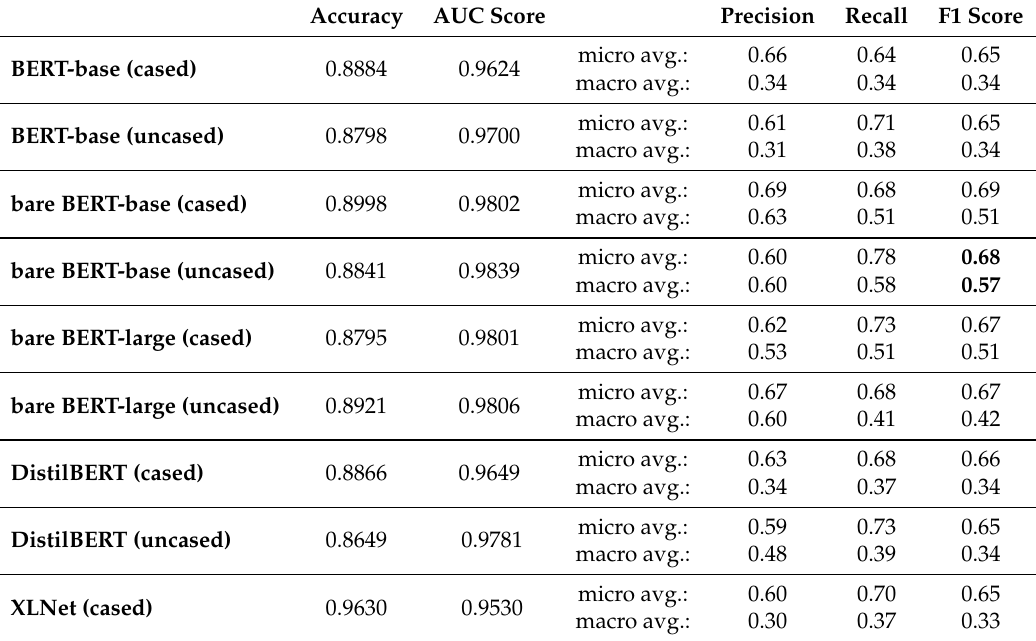
Table 10. Performance of the transformer models.